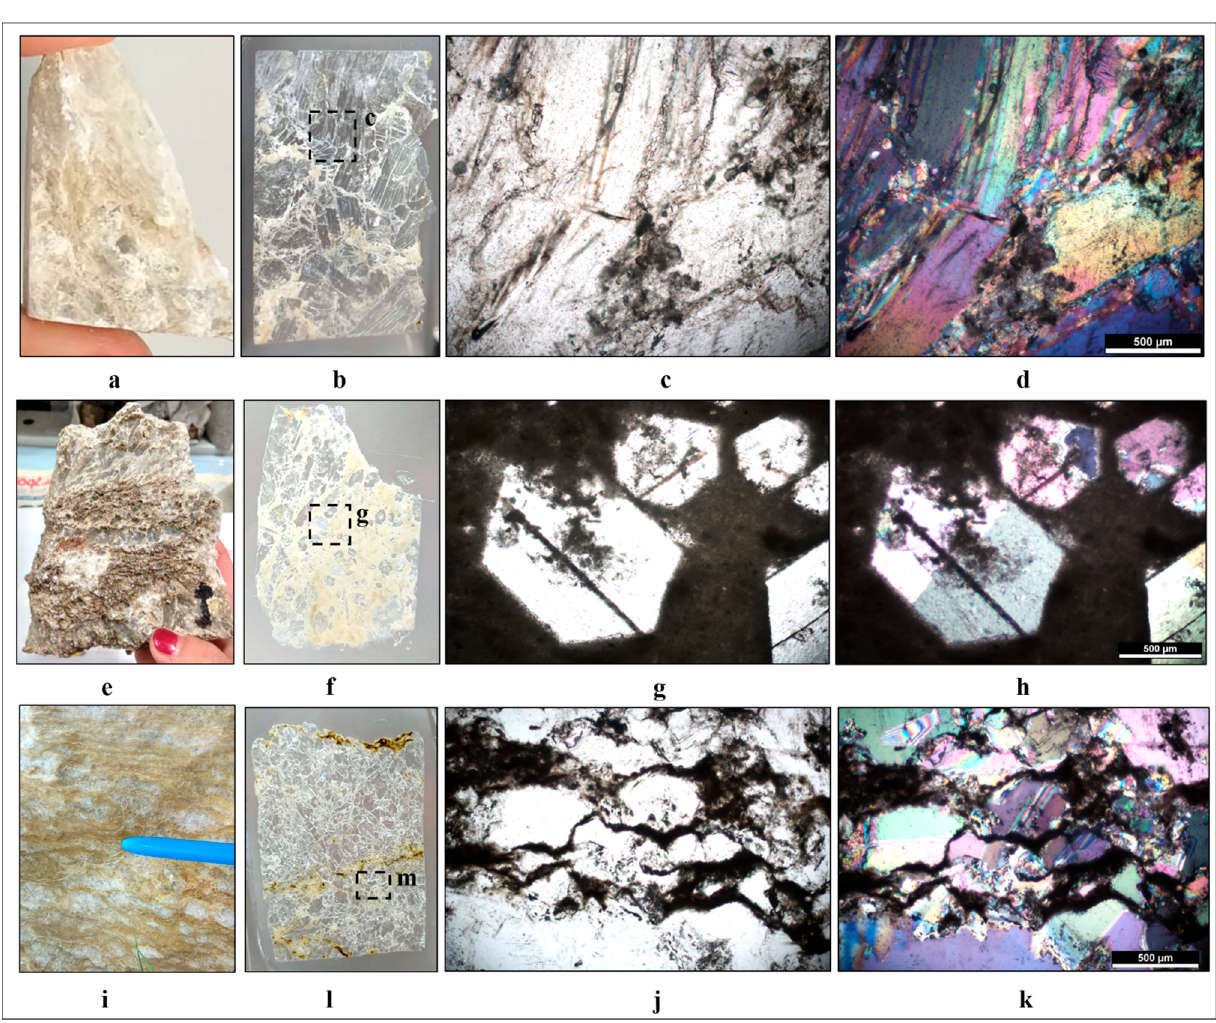
Figure 3. ( a , e , i ) macroscopic samples (5 cm, 10 cm and 15 cm respectively) used to prepare wafers; ( b ) wafer (4cm in length) belonging to the gypsrudites facies, showing crystals >1 cm with chaotical orientation; ( c , d ) magnification (black dashed line in ( b )) of crystals investigated under plane polarized light (PPL) and crossed polarized light (XPL) displaying elongated and folded selenite crystals; ( f ) wafer (4cm in length) belonging to the gypsrudites facies, showing crystals <1 cm occurring in group or isolated and immersed in brown matrix; ( g , h ) magnification (black dashed line in g ) of hexagonal crystals investigated under PPL and XPL displaying twin plane; ( j , k ) magnification (black dashed line in l ) of irregular crystals investigated under PPL and XPL; ( l ) wafer (4 cm in length) from the branching-like facies showing crystals <1 cm with chaotical orientation.